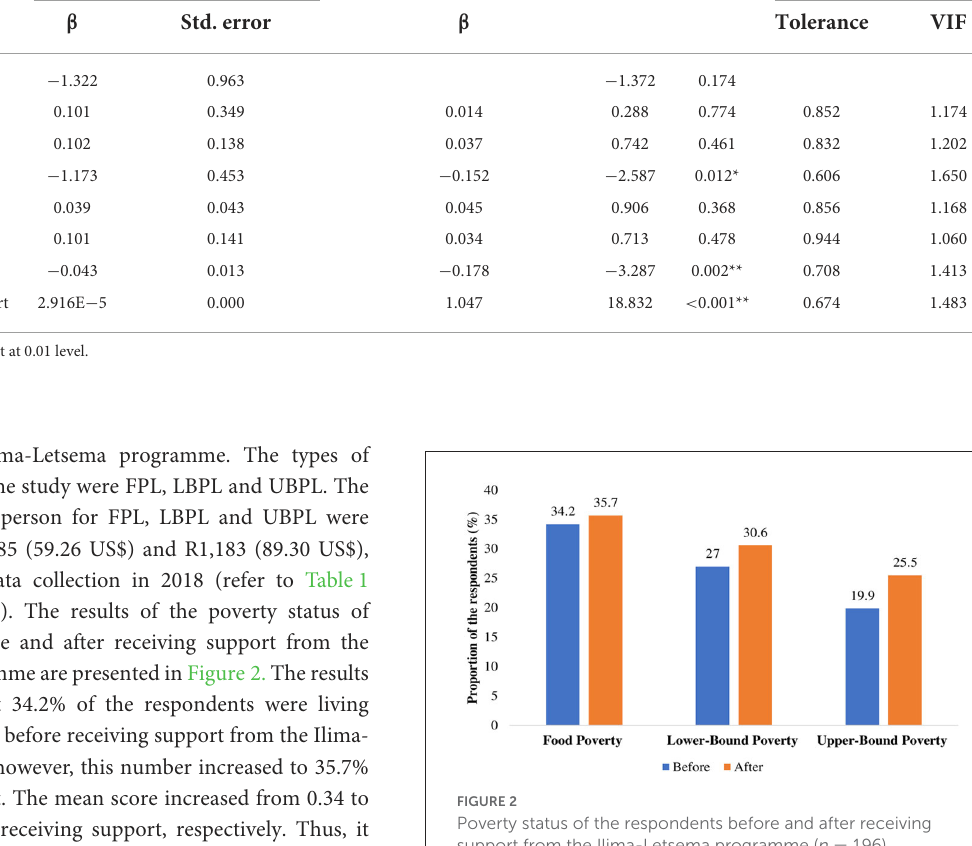
TABLE 5 Multiple linear regression results of the factors influencing job creation in the post-support ( n = 196). Model